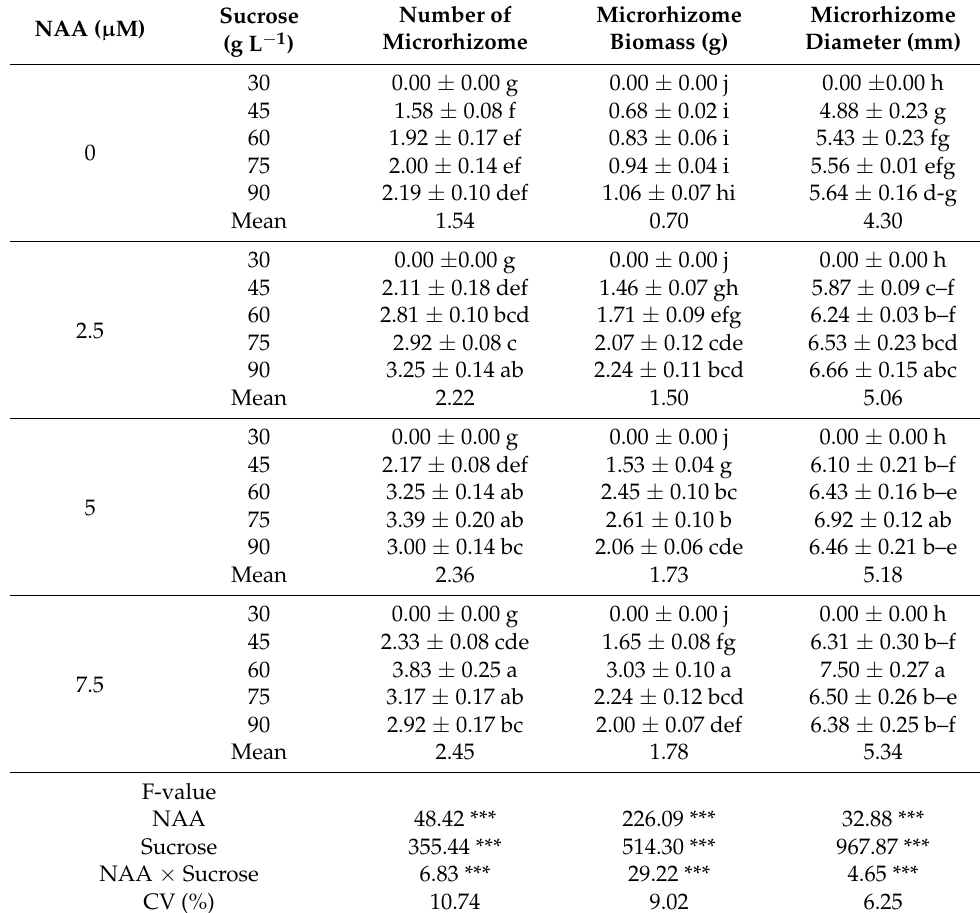
Table 3. Effects of different sucrose and NAA concentrations on microrhizome induction of Bentong ginger in MS medium supplemented with 10 µ M of zeatin after 12 weeks of